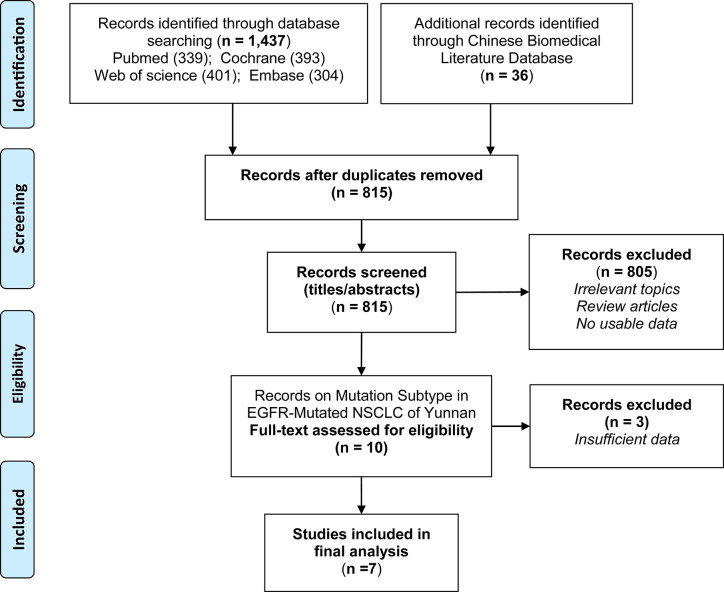
Flow chart detailing the search strategy and identification of studies.